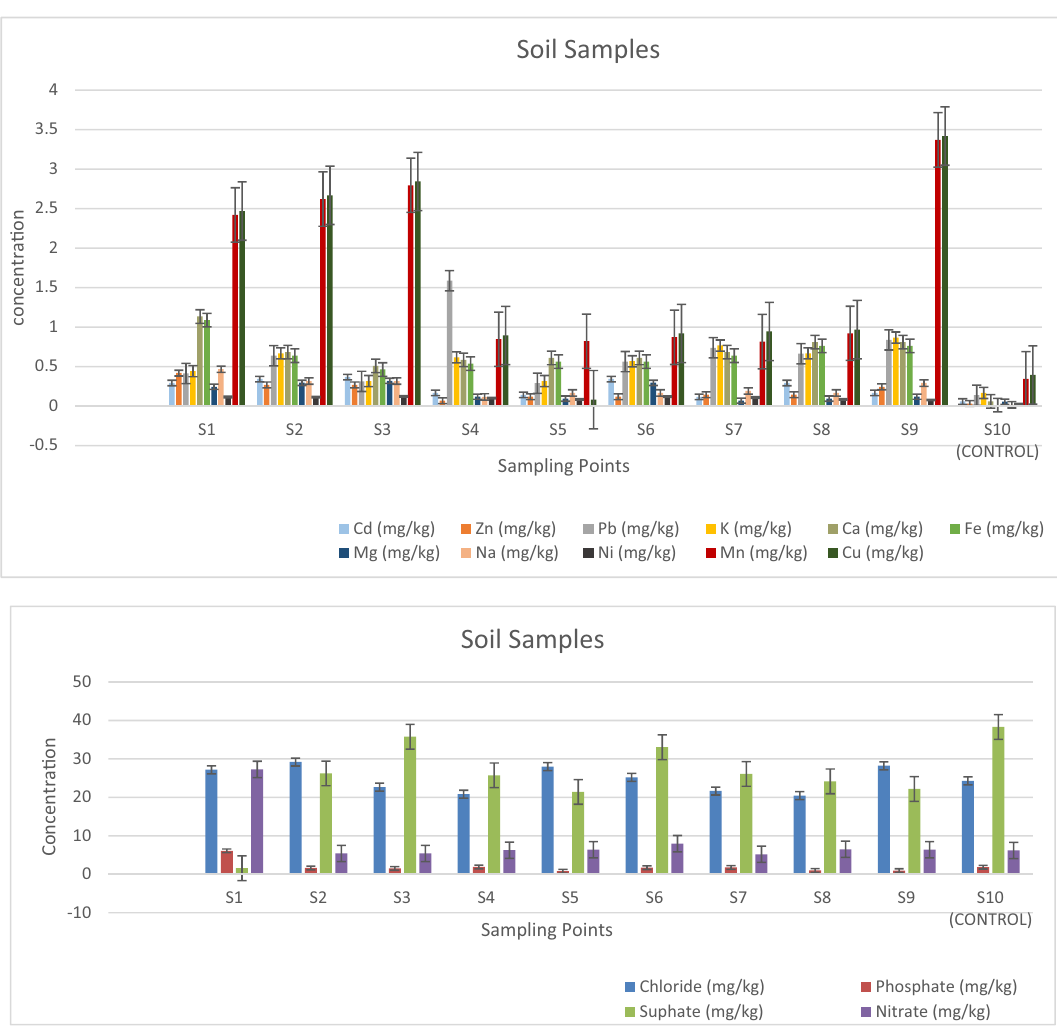
Figure 3. ( a ) Variation Plot of Heavy Metals Concentration across Sampling Points. ( b ) Variation Plot of Anions Concentration across Sampling